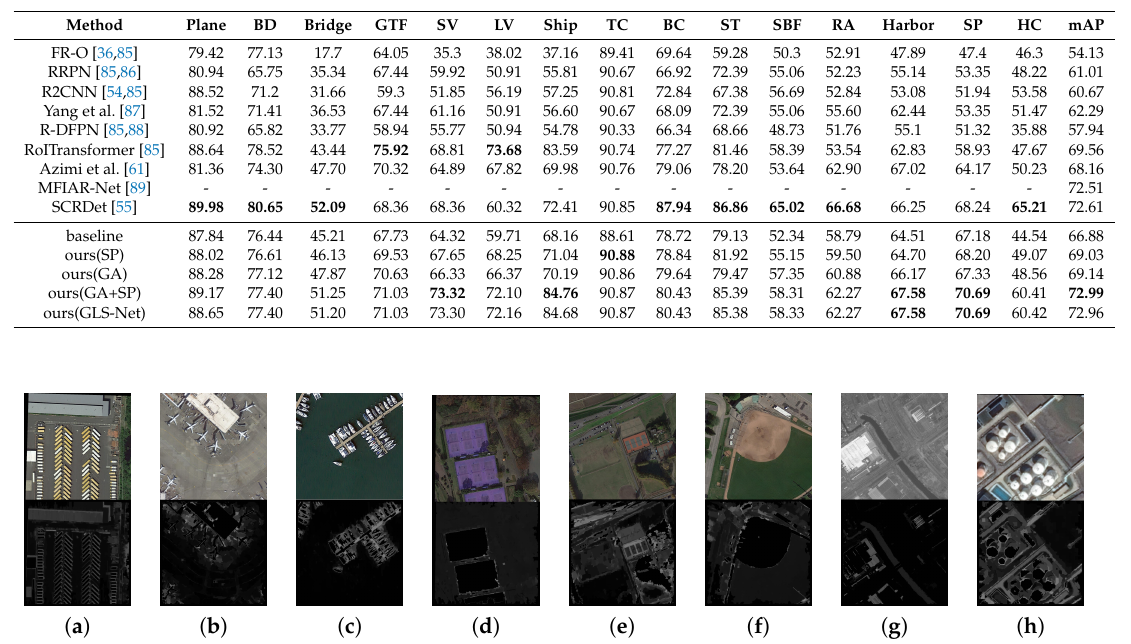
Table 1. Comparisons with the state-of-the-art detectors in the DOTA test dataset [11]. The baseline is the Faster RCNN detector with the FPN and the convolutional head. GA means a network with only the global attention network based on the baseline. SP means a network with only the saliency pyramid based on the baseline. GA+SP means that the global attention network, the saliency pyramid, and the baseline were used at the same time. Finally, GLS-Net is a network adding the angle-sensitive NMS to GA+SP. In addition, the specific meanings of the following abbreviations are: plane, baseball diamond (BD), bridge, ground track field (GTF), small vehicle (SV), large vehicle (LV), ship, tennis court (TC), basketball court (BC), storage tank (ST), soccer-ball field (SBF), roundabout (RA), harbor, swimming pool (SP), and helicopter (HC). The bold Numbers denote The highest values in each column.